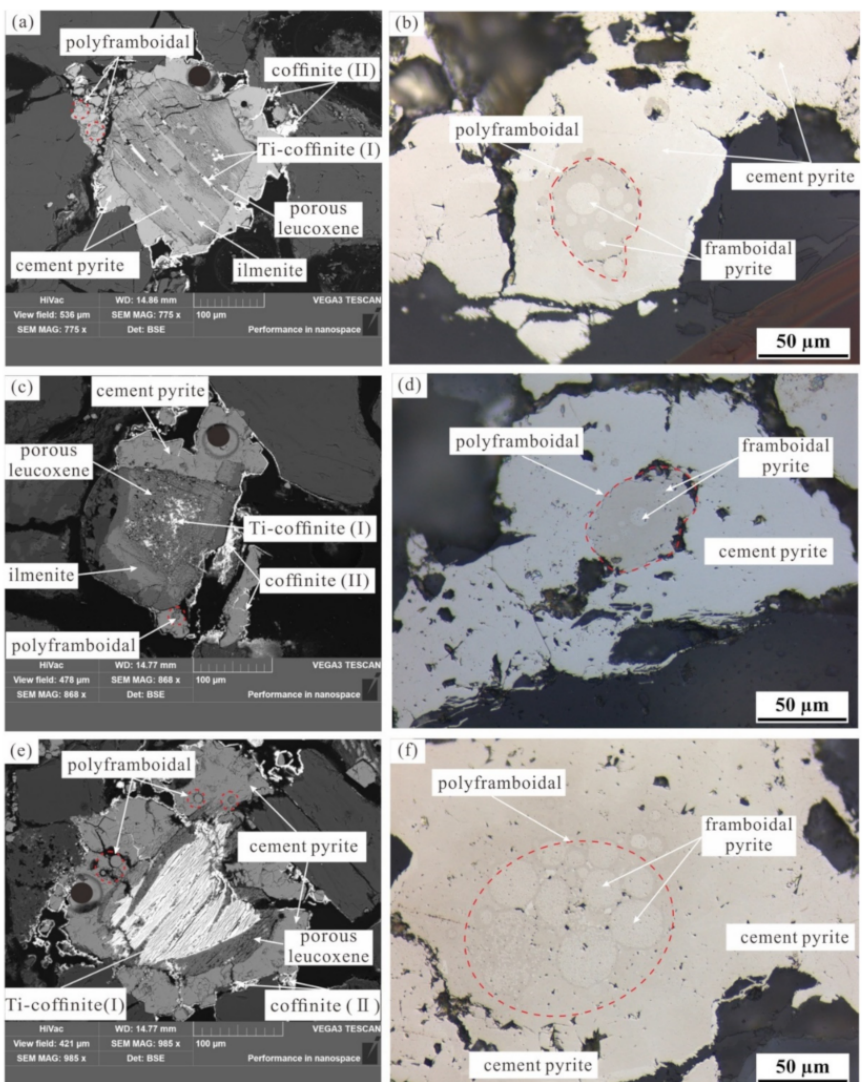
Figure 5. In situ sulfur isotopic composition characteristics of pyrite and its relationship with altered ilmenite and U minerals in the Nalinggou U deposit in the northern Ordos Basin. ( a ) Ti-coffinite produced in the pores of leucoxene and crack of altered ilmenite, coated by cement pyrite and coffinite (SE). ( b ) Polyframboidal pyrite comprising some framboids and coated by cement pyrite. ( c ) Ti-coffinite produced in the pores of leucoxene and coated by cement pyrite and coffinite (SE). ( d ) Polyframboidal pyrite comprising some framboids and coated by cement pyrite. ( e ) Ti-coffinite produced in the pores of leucoxene and coated by cement pyrite and coffinite (SE). ( f ) Polyframboidal pyrite comprising some framboids and coated by cement